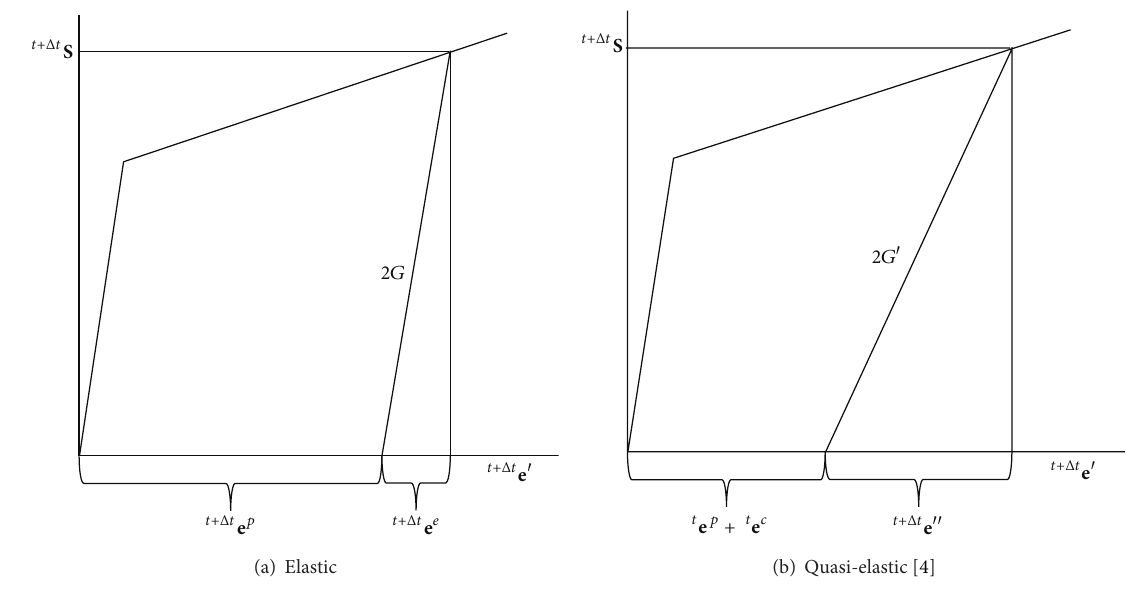
Figure 1: First stage constitutive modulus.